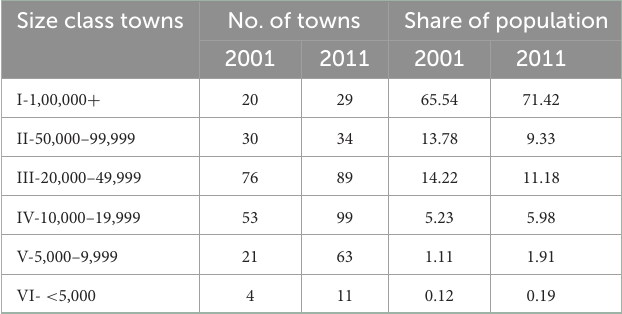
TABLE 3 Number of towns and share of the population, Gujarat-2001 to